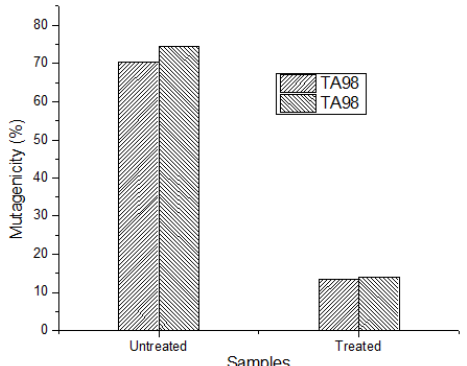
Figure 12. Mutagenicity analysis of Reactive Yellow 160A before and after treatment (TiO 2 = 450 mg/L, RY ‐ 160A = 30 mg/L, H 2 O 2 = 0.8 mL, irradiation time = 120 min).